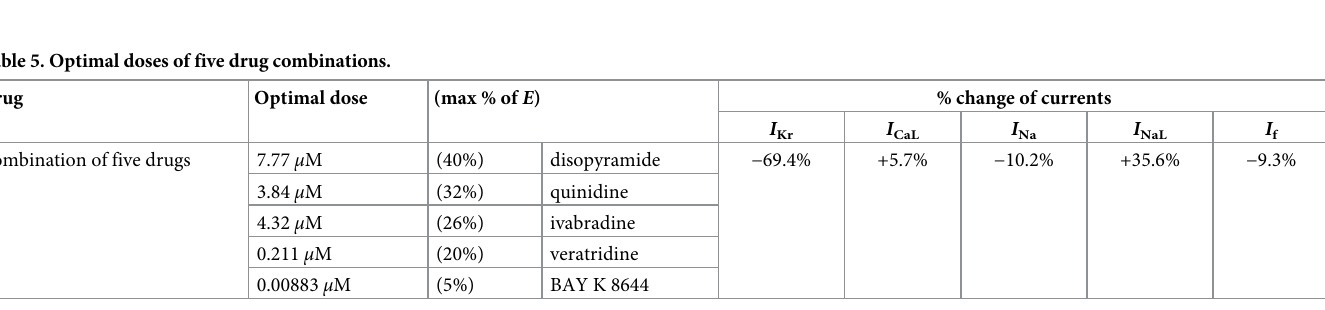
Optimal doses of a combination of five drugs with the restriction D � min(EC 50 )/2 found for repairing the SQT1 mutation in adult human ventricular CMs. This table follows the format of Table